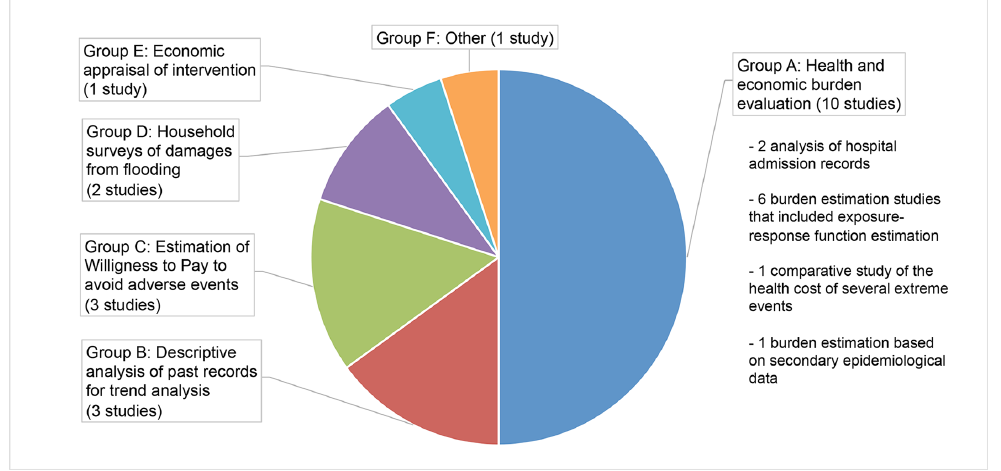
Figure 3. Typology of evaluation undertaken by the identified